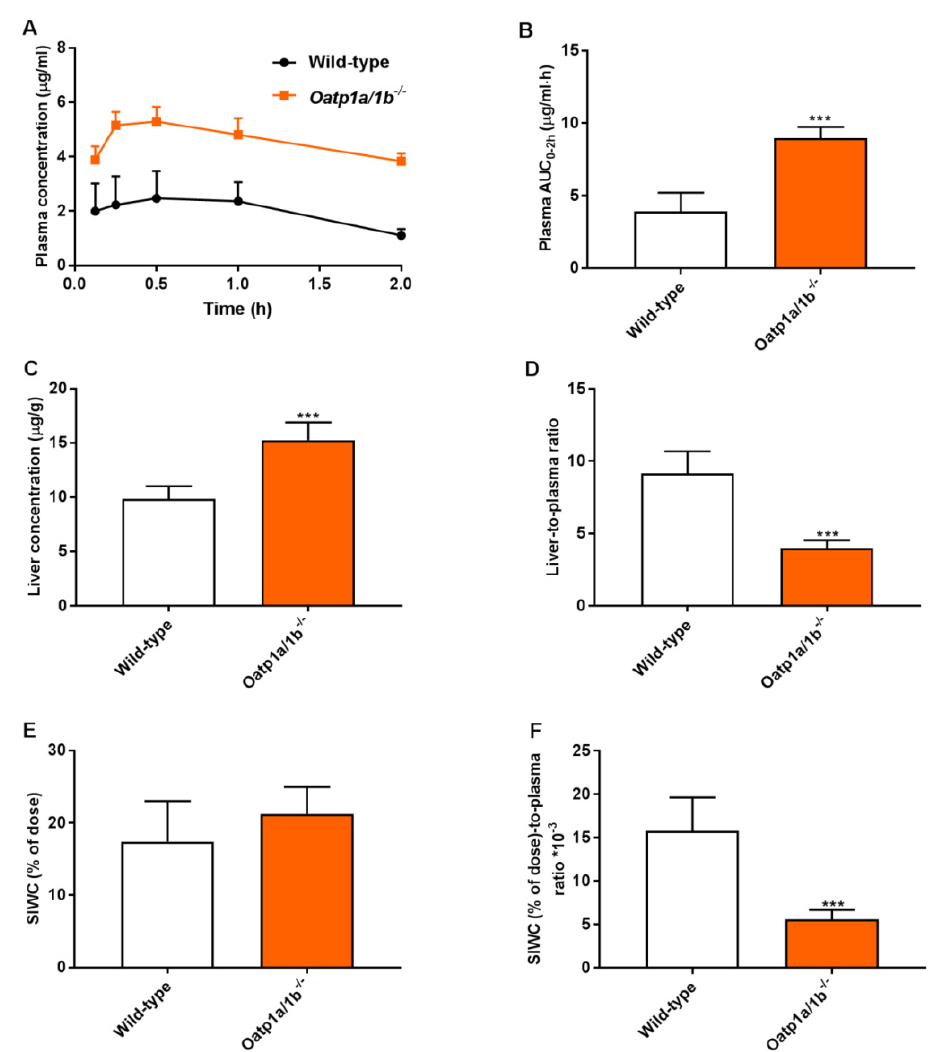
Figure 4. Plasma concentration-time curves ( A ), plasma AUC 0–2h ( B ), liver concentration ( C ), small intestine with content (SIWC) as percentage of dose (E), and liver- and SIWC (% of dose)-to-plasma ratios ( D , F ) of repotrectinib in male wild-type and Oatp1a/1b − / − / − mice 2 h after oral administration of 10 mg/kg repotrectinib. SIWC (% of dose), drug percentage of dose in small intestine with content, which was expressed as total repotrectinib in SIWC divided by total drug administered to the mouse. Data are presented as mean ± S.D. (n = 6–7). *, P < 0.05; **, P < 0.01; ***, P < 0.001 compared to wild-type mice.